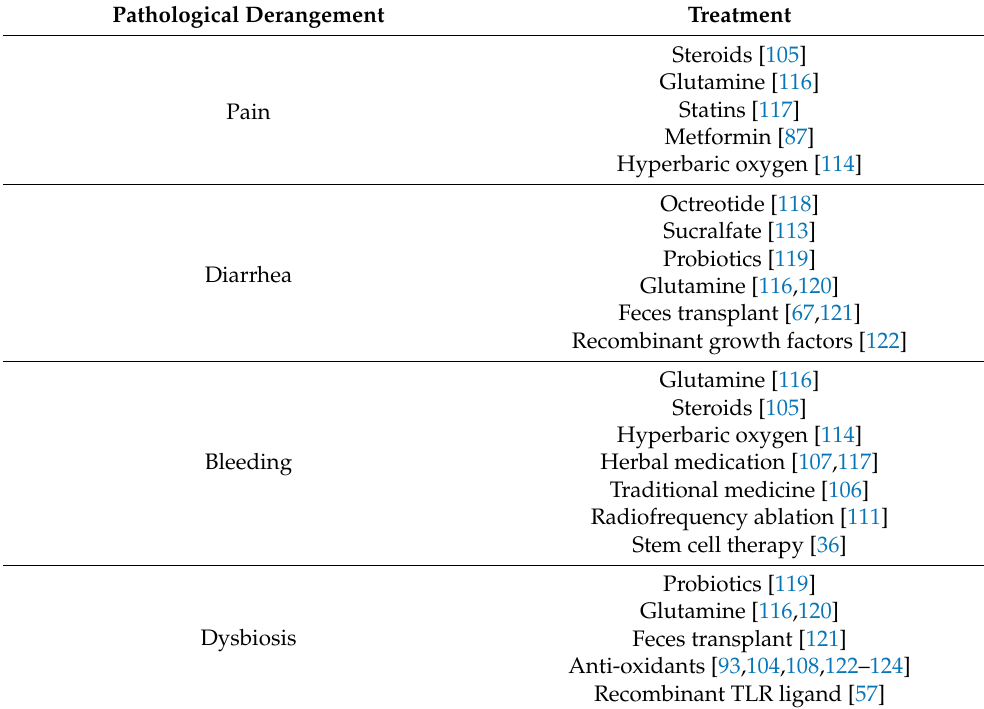
Table 3. Surgical intervention in patients who have radiation enteritis is associated with high rates of postoperative complications including anastomotic breakdown, iatrogenic small bowel fistula, dehiscence of abdominal wound, and recurrence of adhesions and strictures [2,38]. Pathological